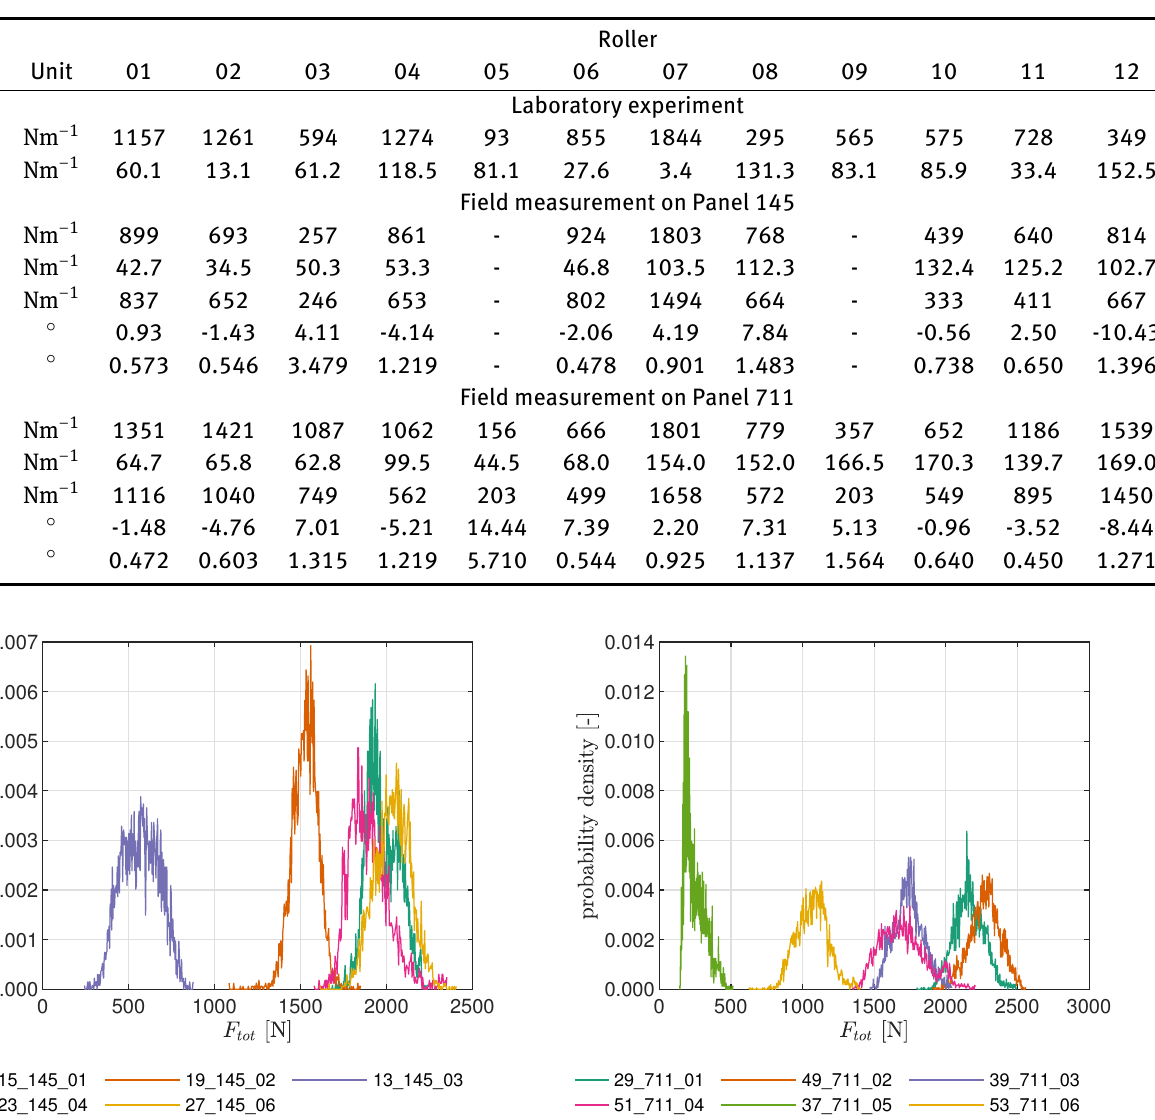
Figure 10: Probability density of the force on the rollers on panel 711 carrying